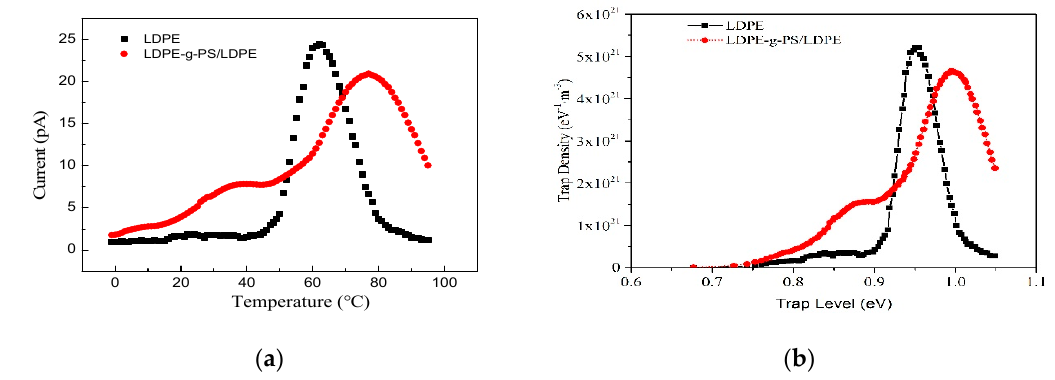
Figure 9. ( a ) TSC lines and ( b ) corresponding trap level distribution of LDPE and LDPE-g-PS / LDPE blend.